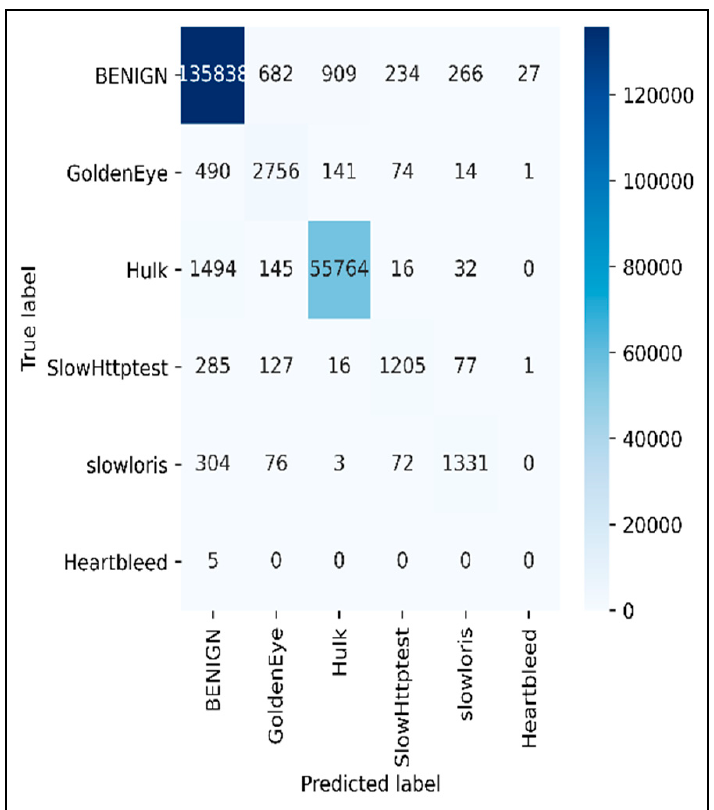
Figure 9. Wednesday confusion matrix data set.